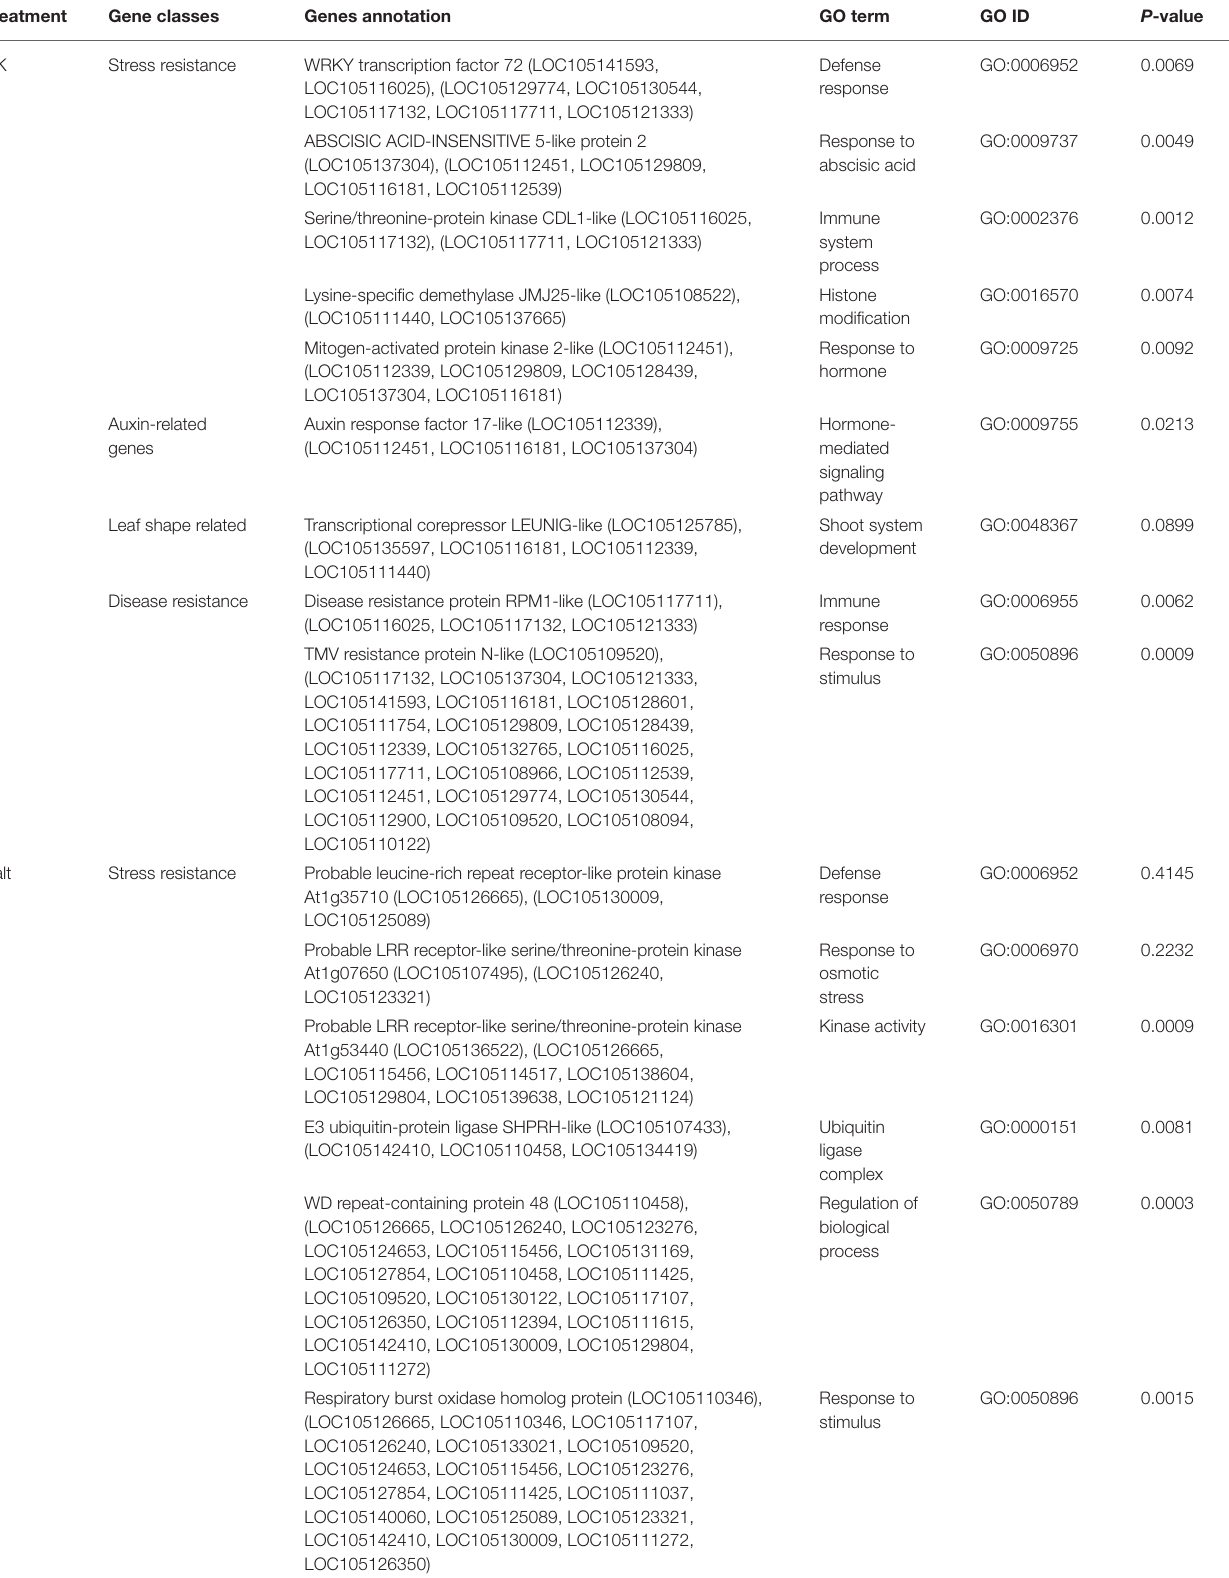
TABLE 2 | Functional categories of significant genes associated with heterophylly in P. euphratica .